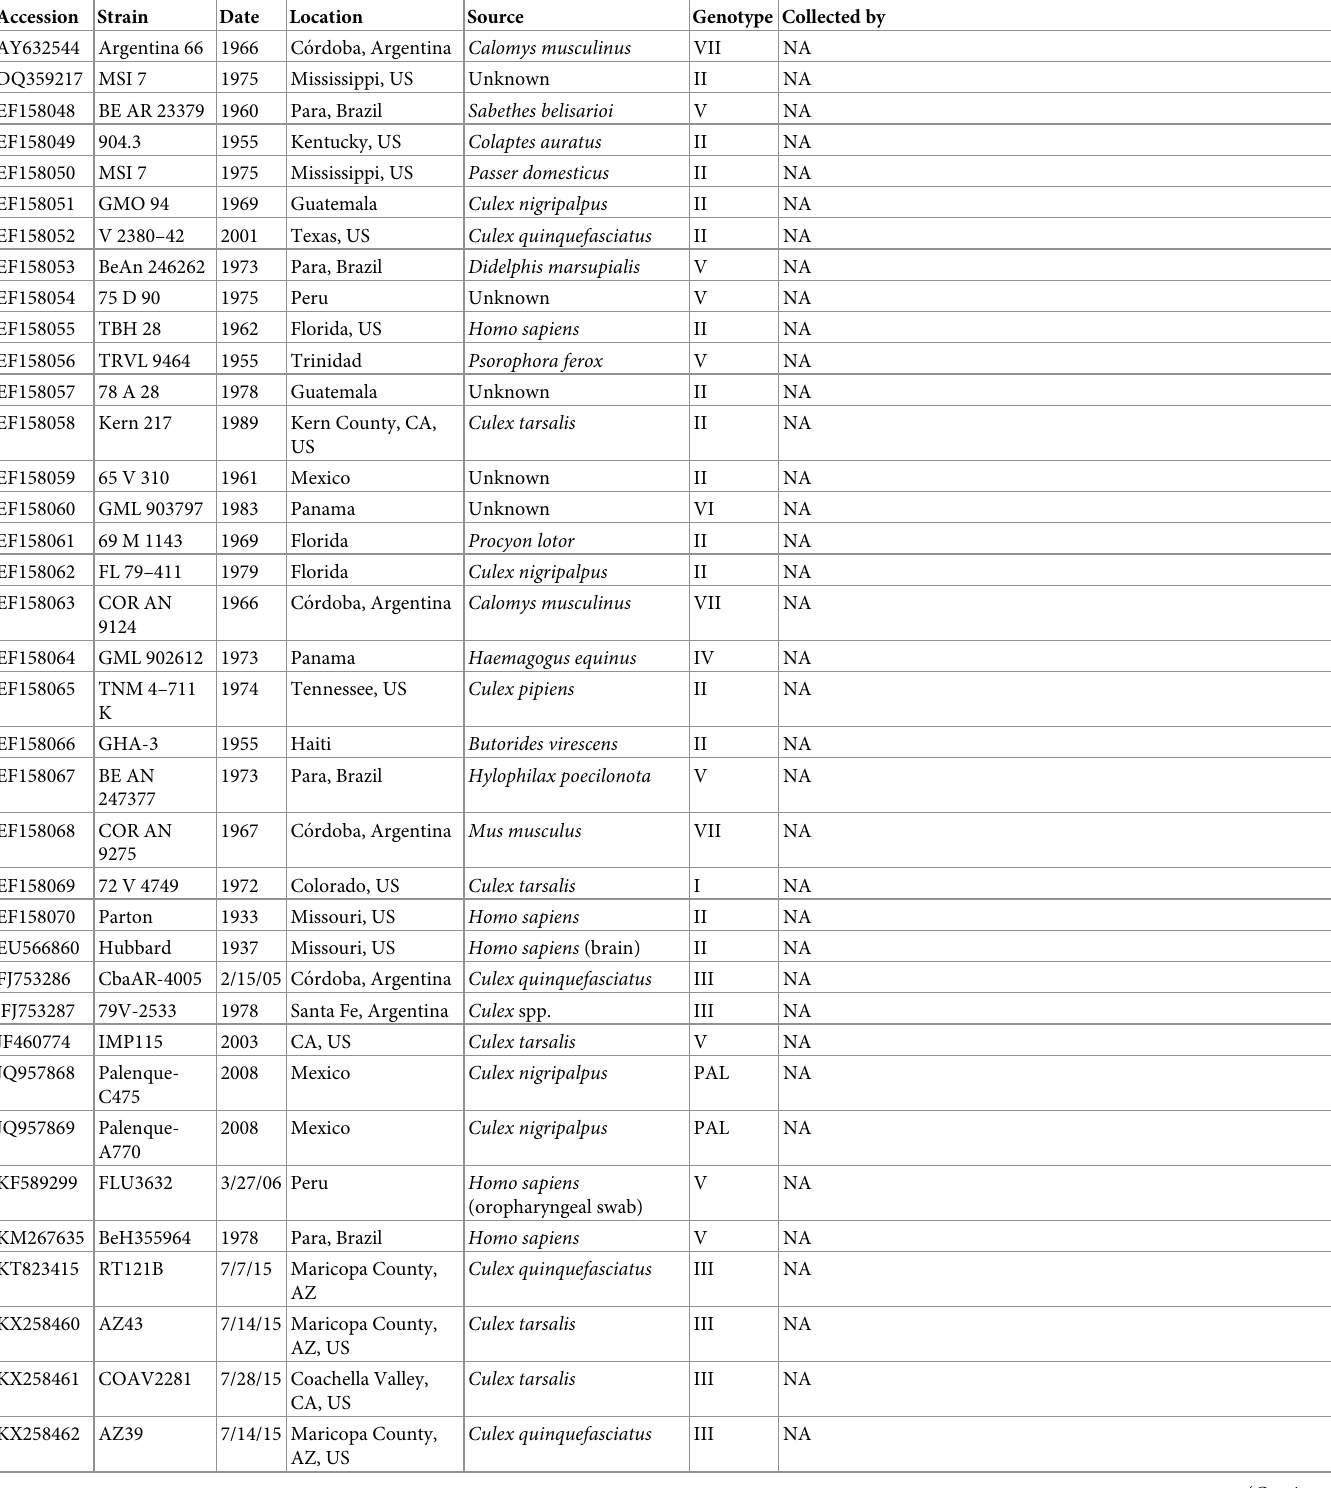
Table 1. SLEV sequences and metadata. Accession